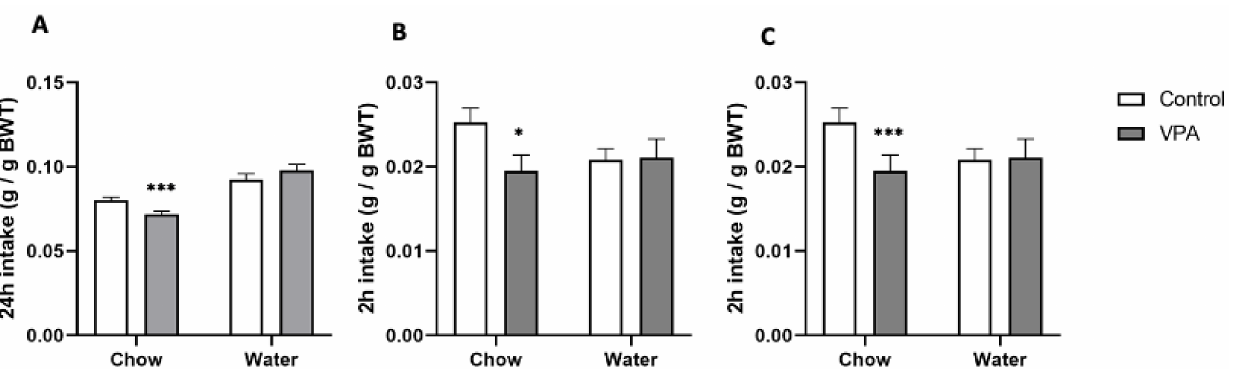
Figure 3. Body weight of adult ASD animals was significantly lower than that of healthy controls. Data are expressed as mean ± SEM, n = 19/group. * p < 0.05, ** p < 0.01.